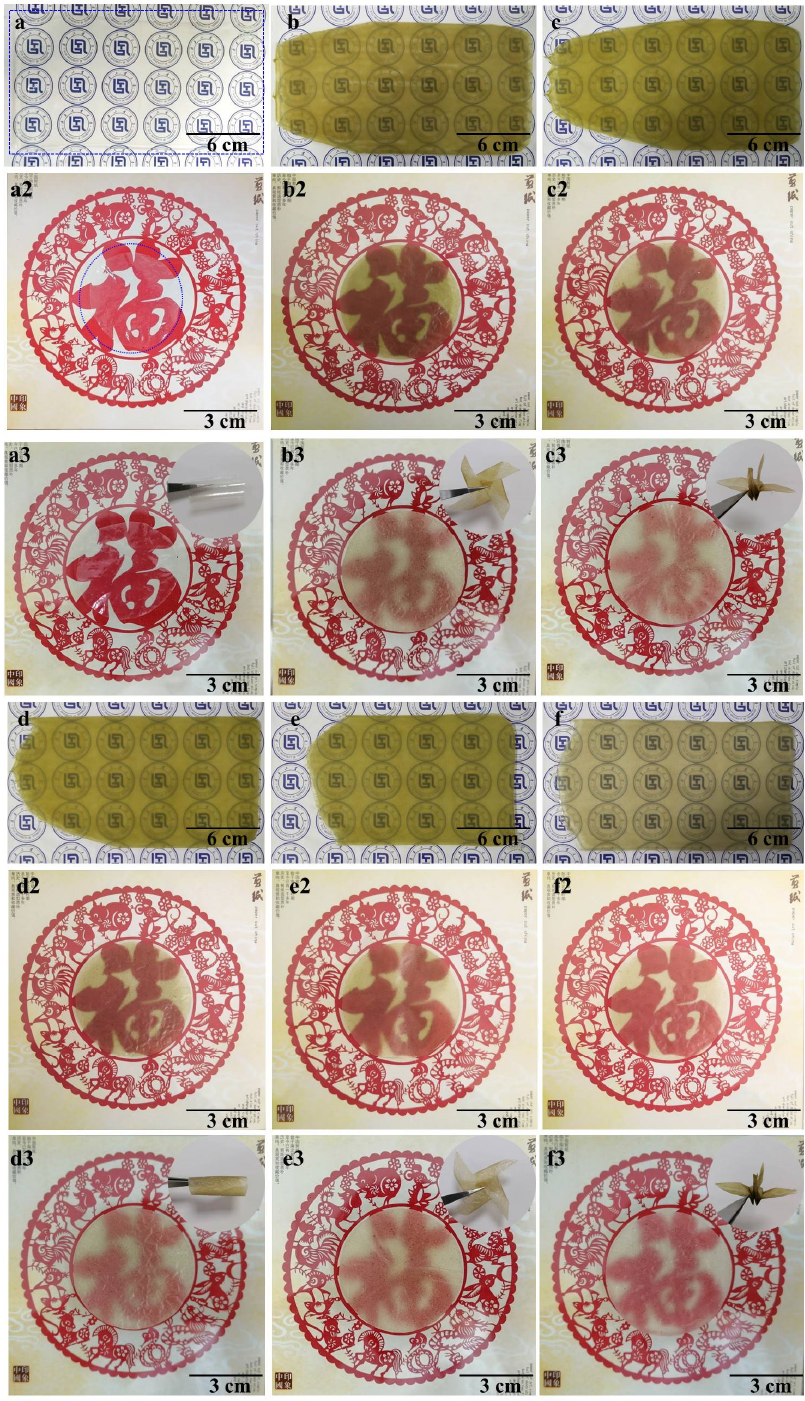
Figure 2. Optical photographs of patterns covered with composite hydrogels (( a ), WPs-gel; ( b ), Gel-WPT10; ( c ), Gel-WPT20; ( d ), Gel-WPT30; ( e ), Gel-WPT40; ( f ), Gel-WPT50), films without distance and films with 10 mm distance (( a2 , a3 ), WPs-film; ( b2 , b3 ), WPT10; ( c2 , c3 ), WPT20; ( d2 , d3 ), WPT30; ( e2 , e3 ), WPT40; and ( f2 , f3 ), WPT50).